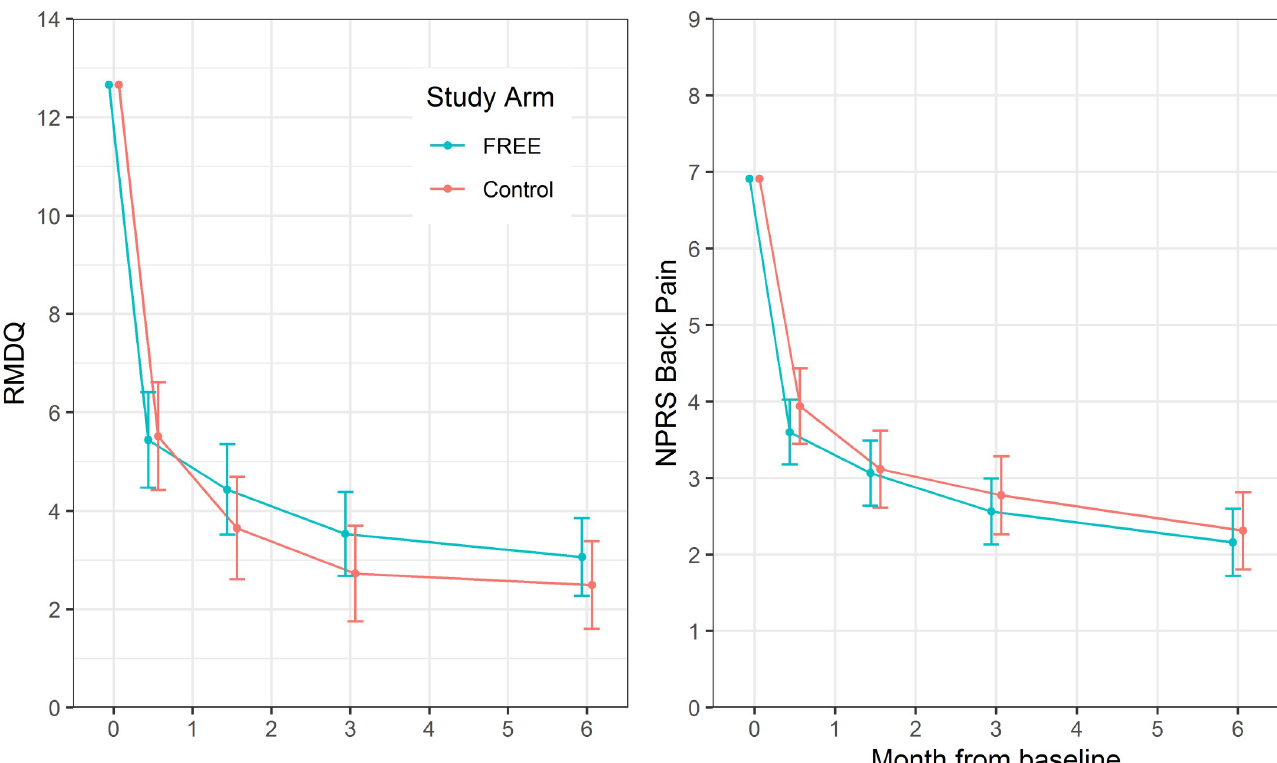
Fig 3. Mean patient participant RMDQ and NPRS scores by study arm at baseline and follow-up. Error bars represent 95% CIs of mean. FREE, Fear Reduction Exercised Early; NPRS, Numeric Pain Rating Scale; RMDQ, Roland Morris Disability Questionnaire.